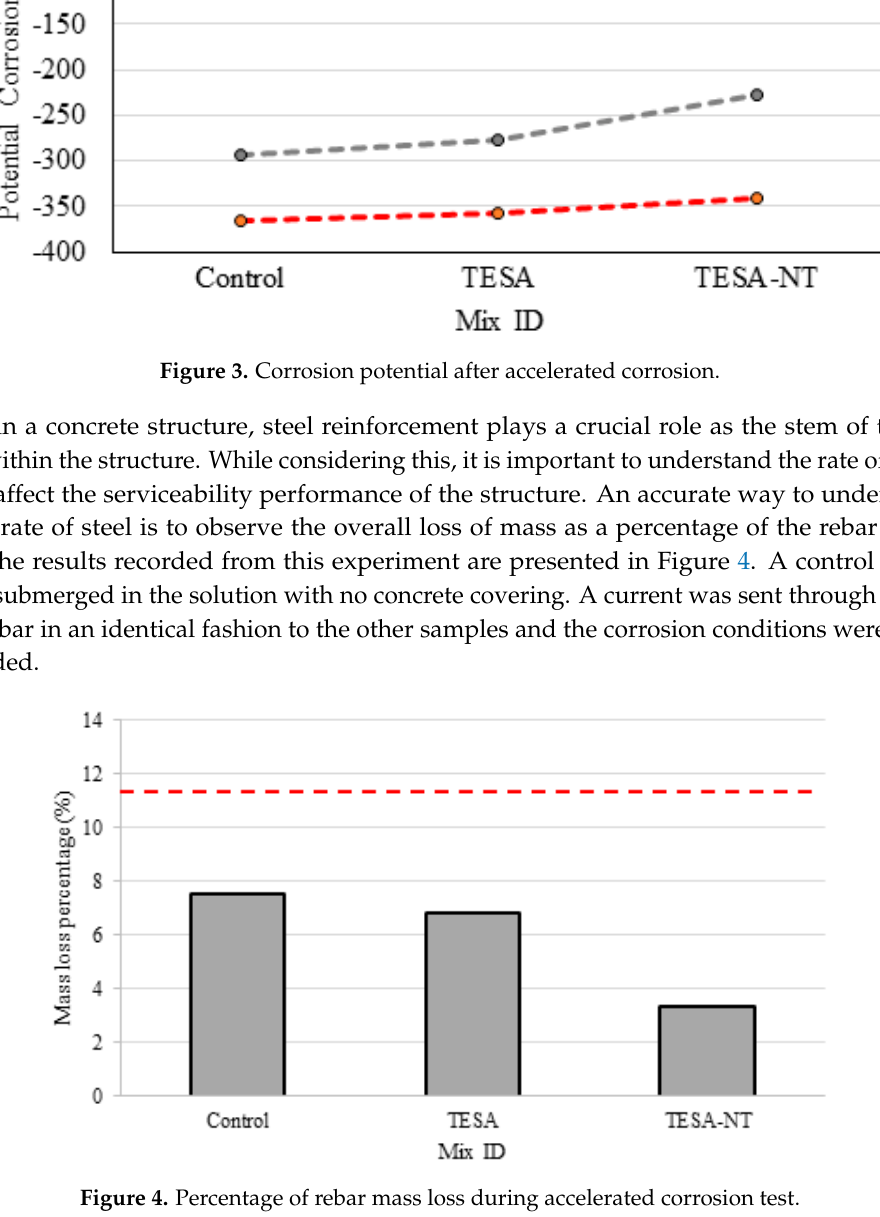
Figure 4. Percentage of rebar mass loss during accelerated corrosion test.